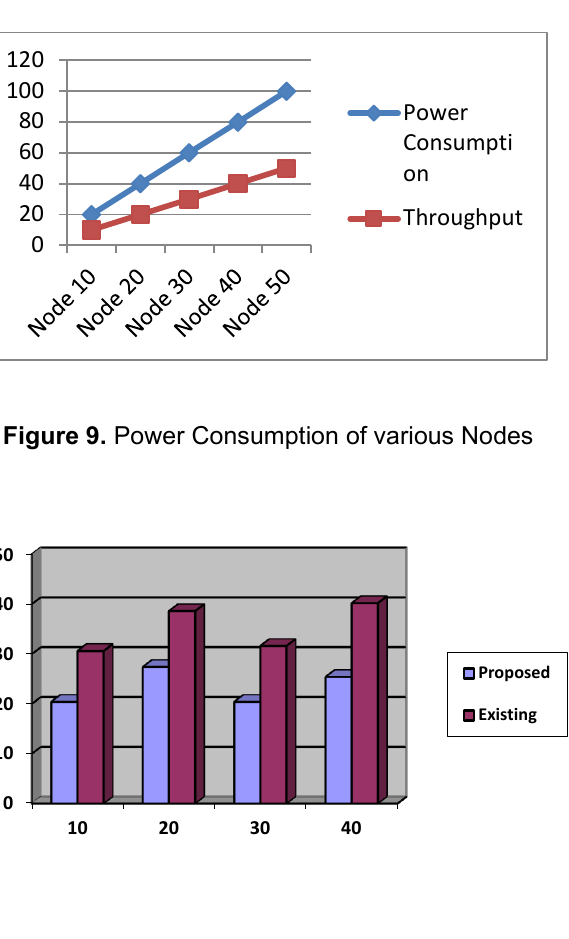
Figure 10. Power Consumption of the Proposed and Existing